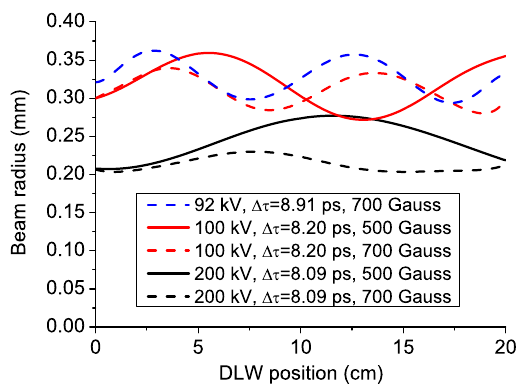
FIG. 4. Beam radius evolutions along the longitudinal DLW position.